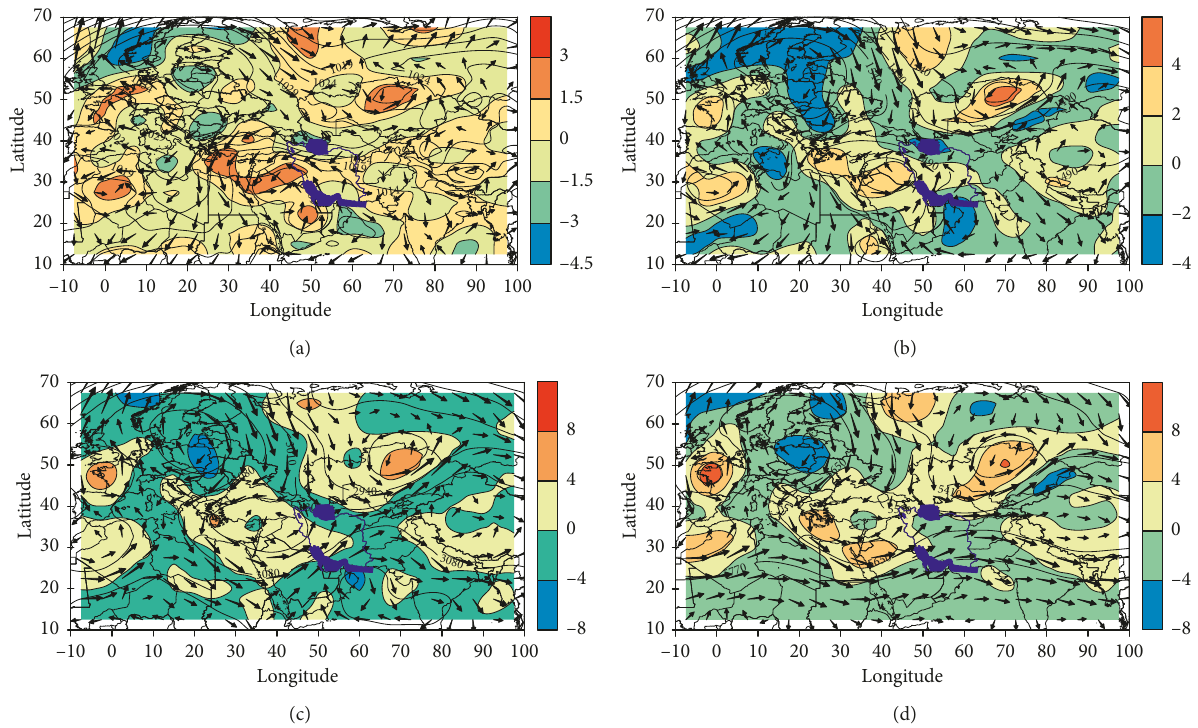
Figure 6: (a) 1000hPa height (contours), vorticity (5 × 10 − 5 (5 × 10 − 5 ), and wind flow (m/s). (c) 700 hPa height, vorticity (5 × 10 − 5 S − 1 wind flow